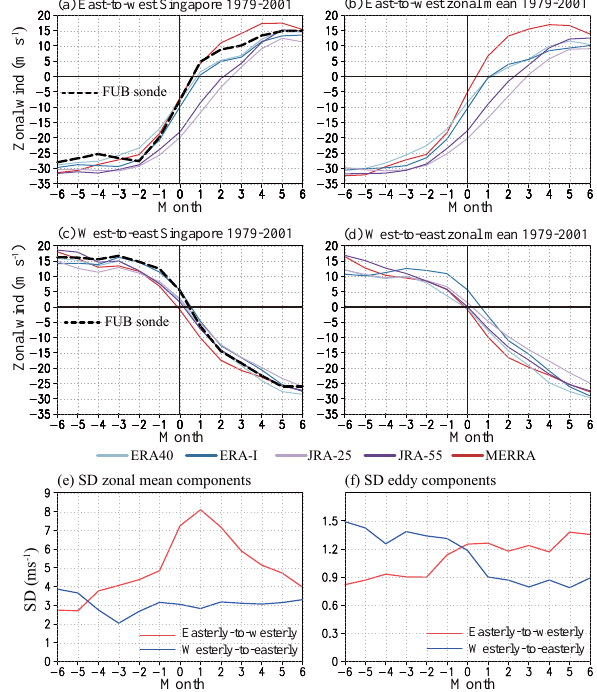
during 1979 to 2001 where month 0 corresponds to (a, b) the easterly-to-westerly transition of the FUB zonal wind at 10hPa and to (c, d) the westerly-to-easterly transition. Color lines show each reanalysis zonal wind, and black dashed lines depict FUB zonal wind in Singapore. Results for (a, c) the zonal wind in Singa- pore and for (b, d) the zonal mean equatorial zonal wind. Bottom: composite of the zonal mean equatorial standard deviation due to (e) zonal mean and (f) eddy components during (red) easterly-to- westerly and (blue) westerly-to-easterly transitions at 10hPa. Note the ordinate axes are different between (e, f)